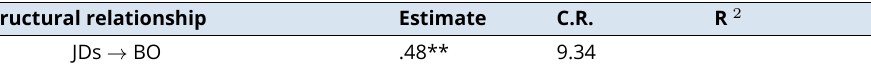
Moderation Analysis Structural